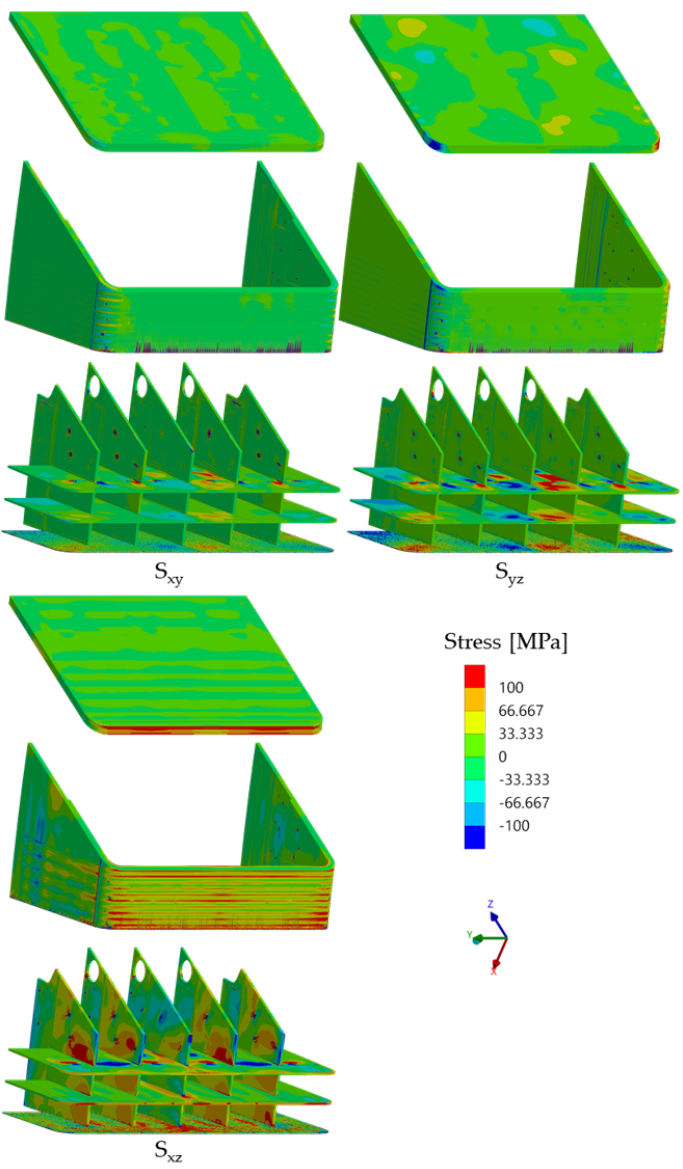
Figure 21. Spatial distribution of the stress tensor shear components within Eurofer